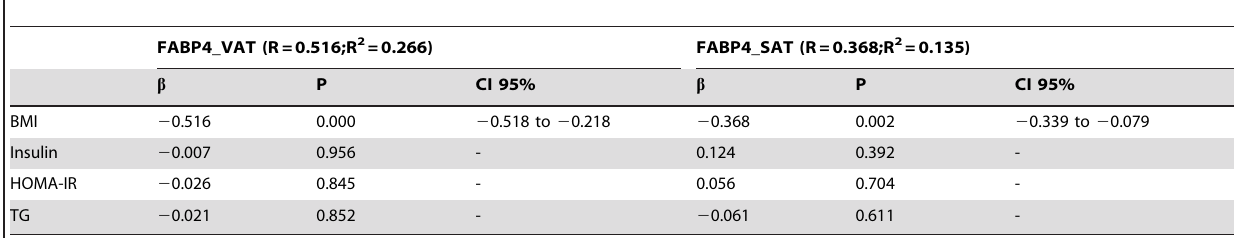
Table 6. Multiple regression analysis for FABP4 gene expression in VAT and SAT, as dependent variable, in all the study